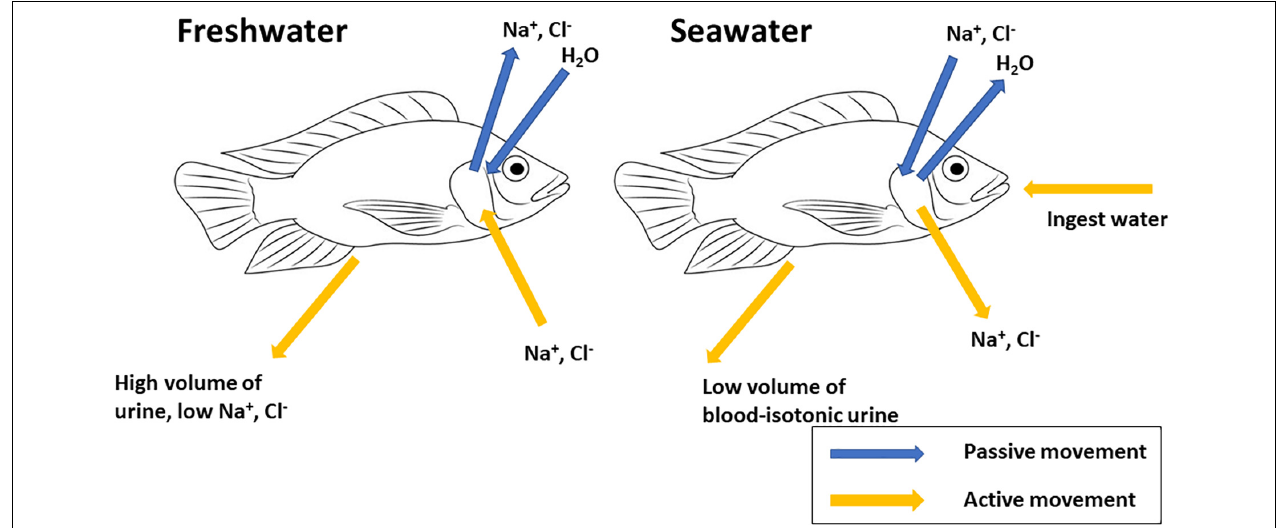
FIGURE 1 | Generalized schematic representation of mechanisms of osmoregulation in teleost fishes. Freshwater fishes are hyper-osmotic to their aquatic environment; compensatory mechanisms include active uptake of NaCl across gill epithelium, intestinal absorption of NaCl and excretion of large volumes of dilute urine. Marine teleosts are hypo-osmotic to their aquatic environment; compensatory mechanisms include active secretion of NaCl across gill epithelium, ingestion of seawater, intestinal absorption of NaCl and water and excretion of small volumes of blood-isotonic